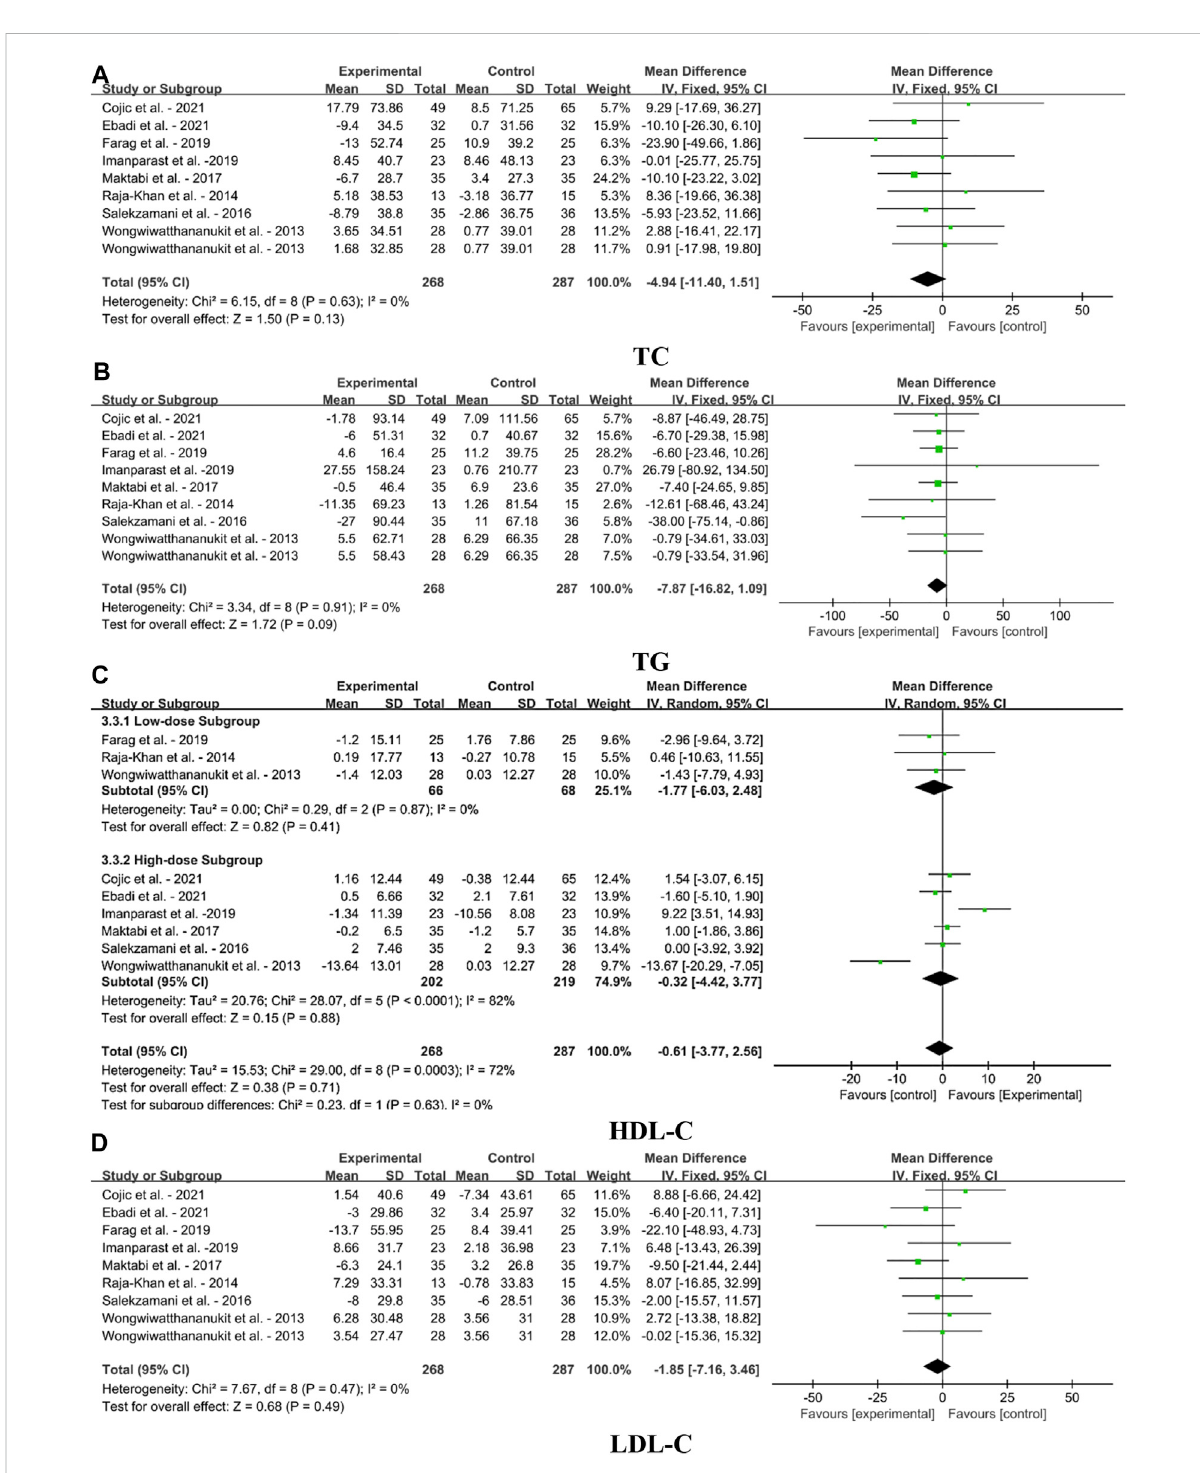
FIGURE 5 Forest plots for the effects of VDS on serum lipid pro fi le in MetS adults. (A) TC: total cholesterol, (B) TG: triglyceride, (C) HDL-C: high-density lipoproteincholesterol, (D) LDL-C: low-density lipoprotein cholesterol. The horizontal bar indicates the 95% con fi dence interval (CI). The size of the rectangle at the center of the horizontal bar is proportional to the weight of the given study. The diamond at the bottom indicates the pooled mean difference